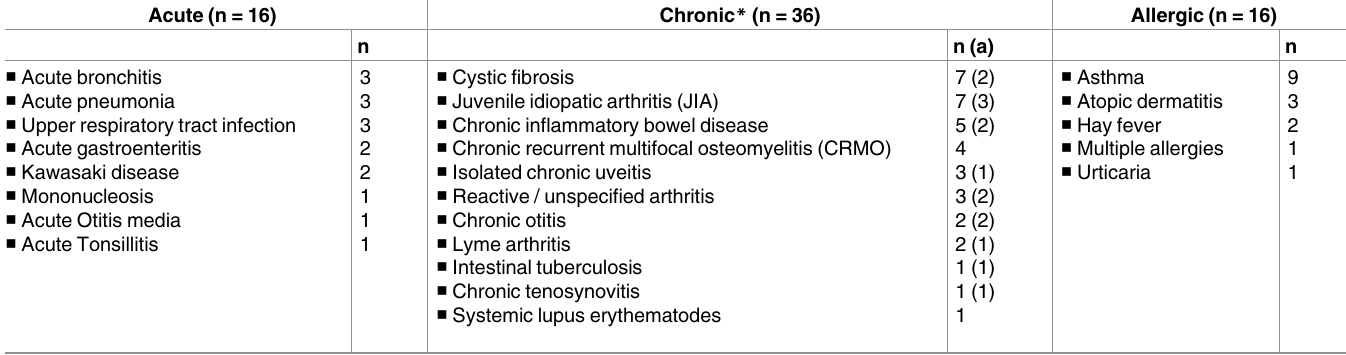
Table 1. Clinical diagnosis of probands in the study groups.